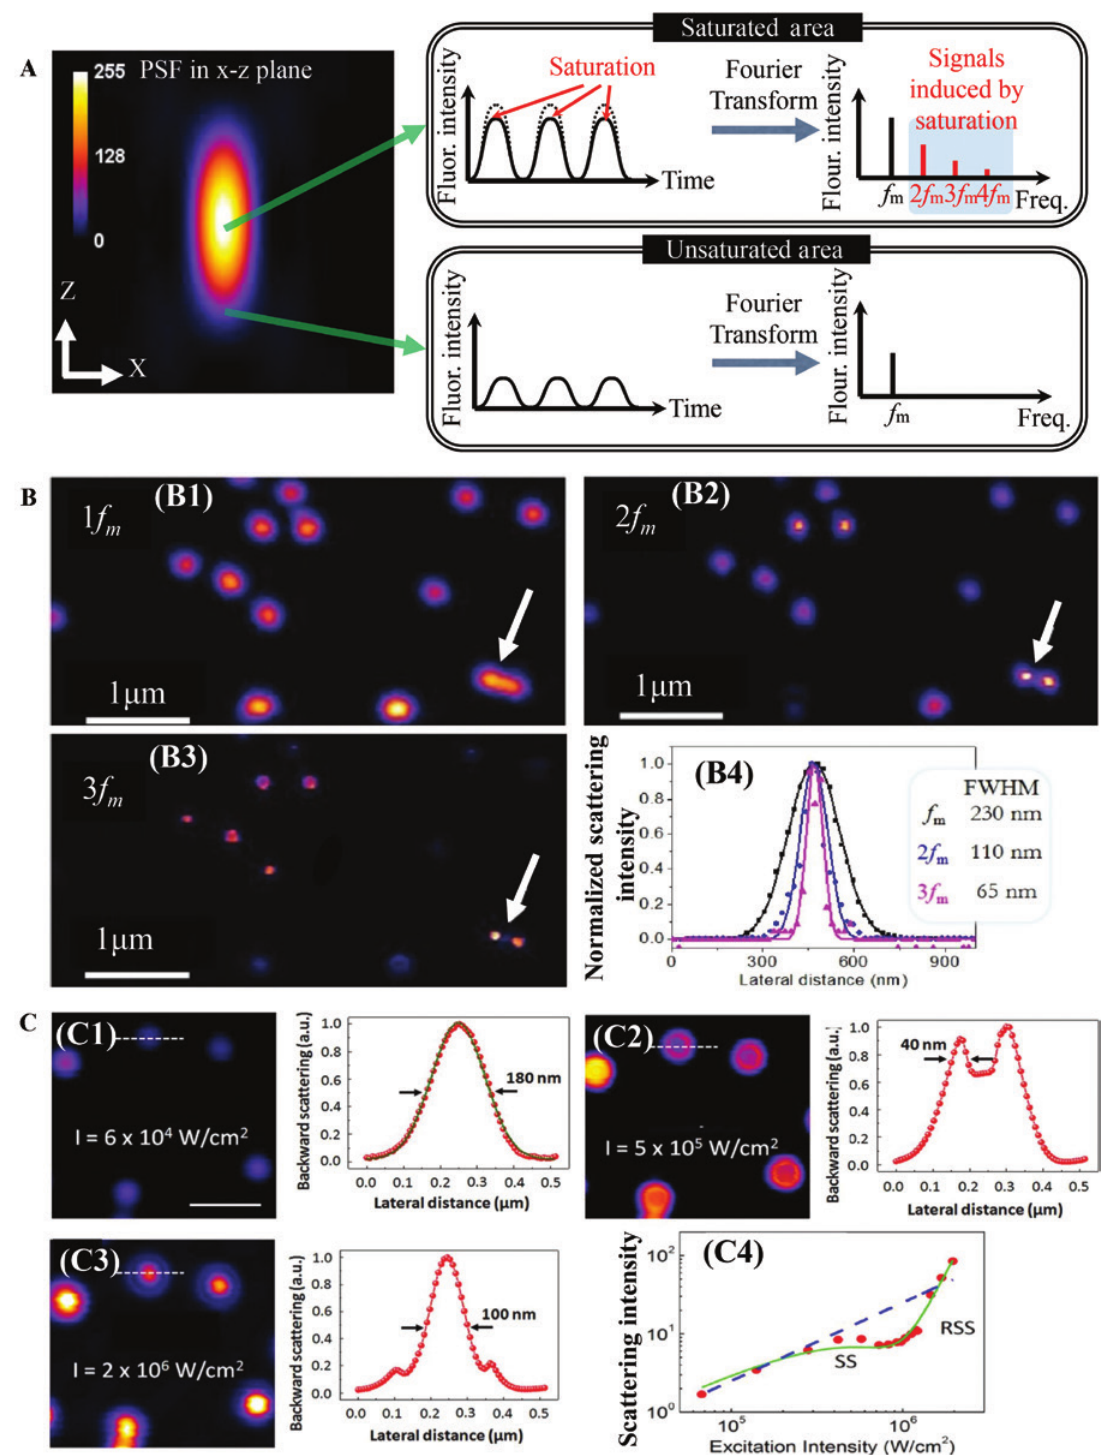
at half-maximum (FWHM) to l /8, which is much smaller than the diffraction limit. Without SAX set-up, from the confocal PSFs of well- separated gold nanoparticles with increasing excita- tion intensity, we find that the inherent nonlinearity